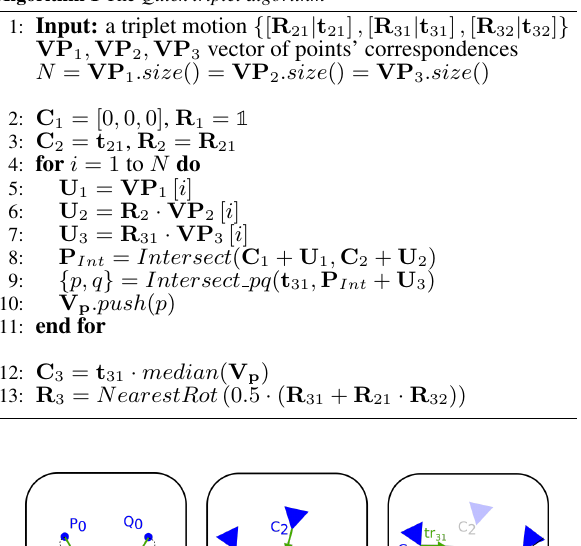
Algorithm 1 The Quick triplet algorithm